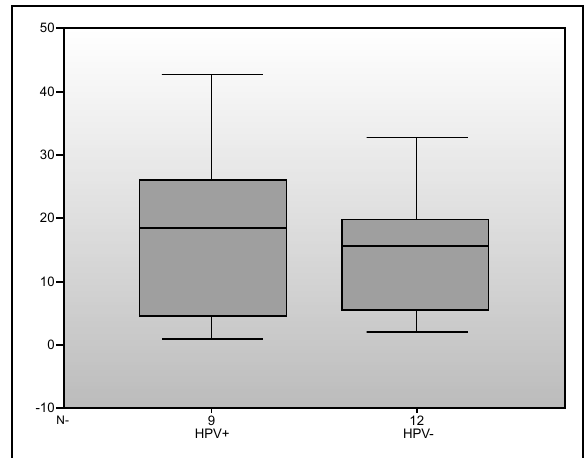
Figura 3 – Box blot indicativo da análise não-paramétrica dos índices de positividade de marcação pelo Ki-67 nos grupos HPV-positivos e HPV-negativos